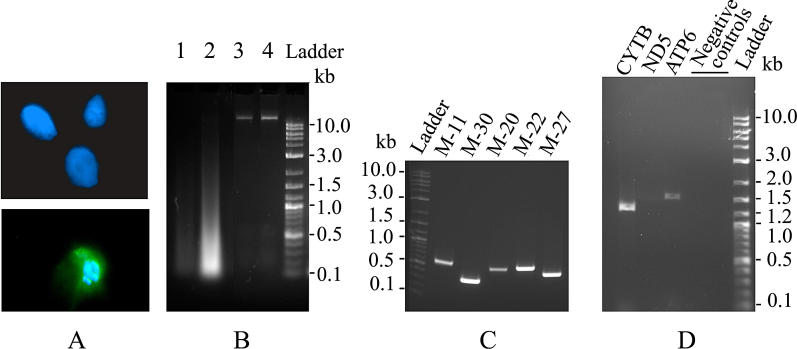
The Unusually Well-Preserved Mammoth DNA(A) Nuclei with DNA clearly detectable by DAPI staining in muscle cells of ~33,000-y-oldM. primigenius. (B) Total genomic DNA isolated from the mammoth muscle tissue (lane 1 is 1/10 dilution of the DNA on lane 2); control DNA from fresh human blood samples in lanes 3 and 4. (C) Examples of PCR products (~300–600 bp) for mammoth mitochondrial genome. (D) PCR amplification recovers long sequences for complete mitochondrial genes (1,317 bpCytB and 1,613 bpATP6 genes), but PCR of larger fragments (3,054 bpND5) is failed.